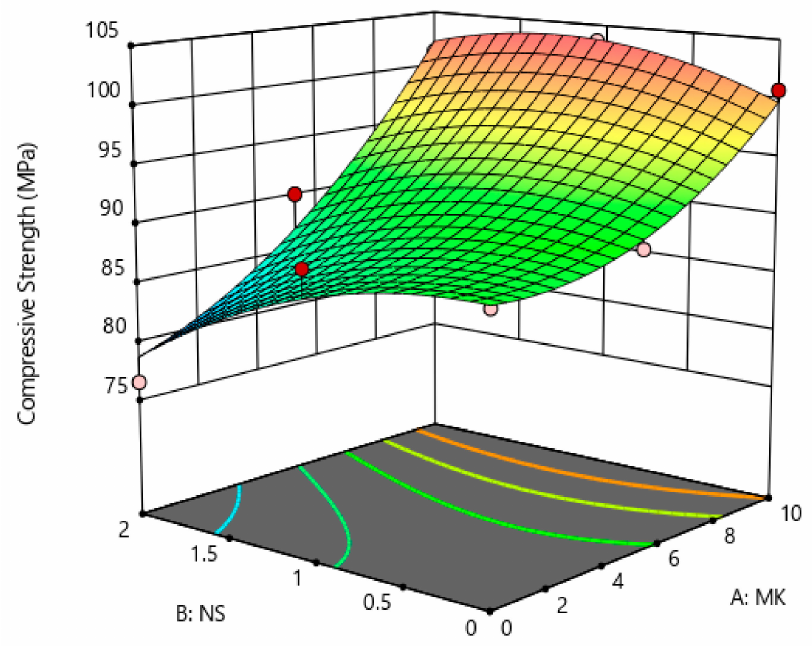
Figure 13. E ff ect MK and NS proportions on compressive